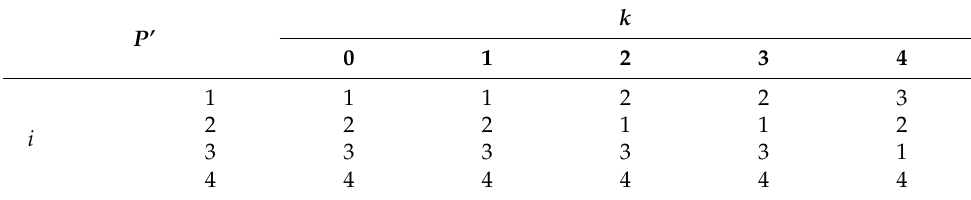
Table 3. A reordered position change matrix P